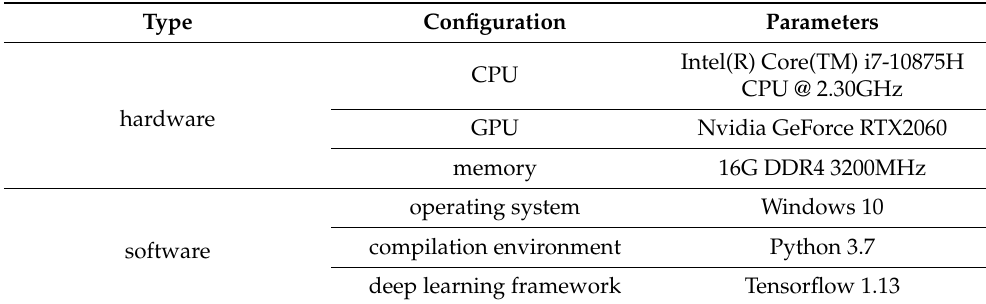
Table 1. The experiment environment’s hardware and